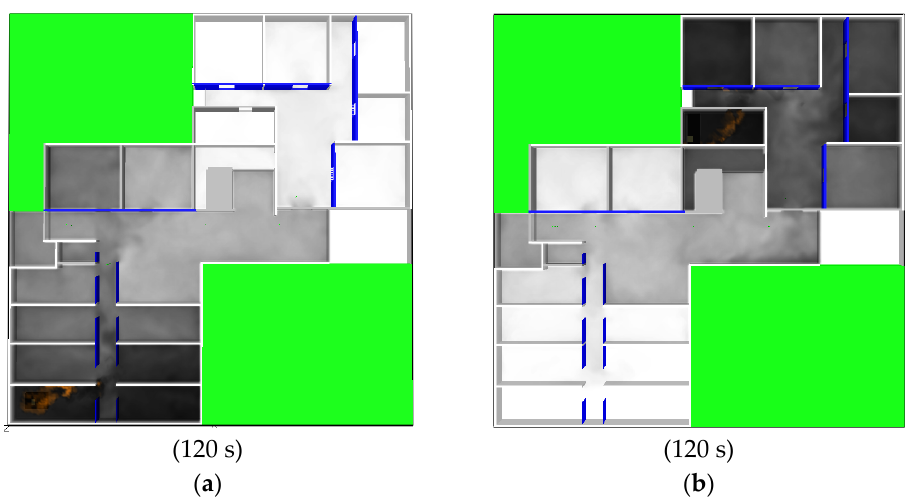
Figure 13. Smoke spread simulation in a nursing home: ( a ) fire point above a bedside, and ( b ) fire point in the kitchen.